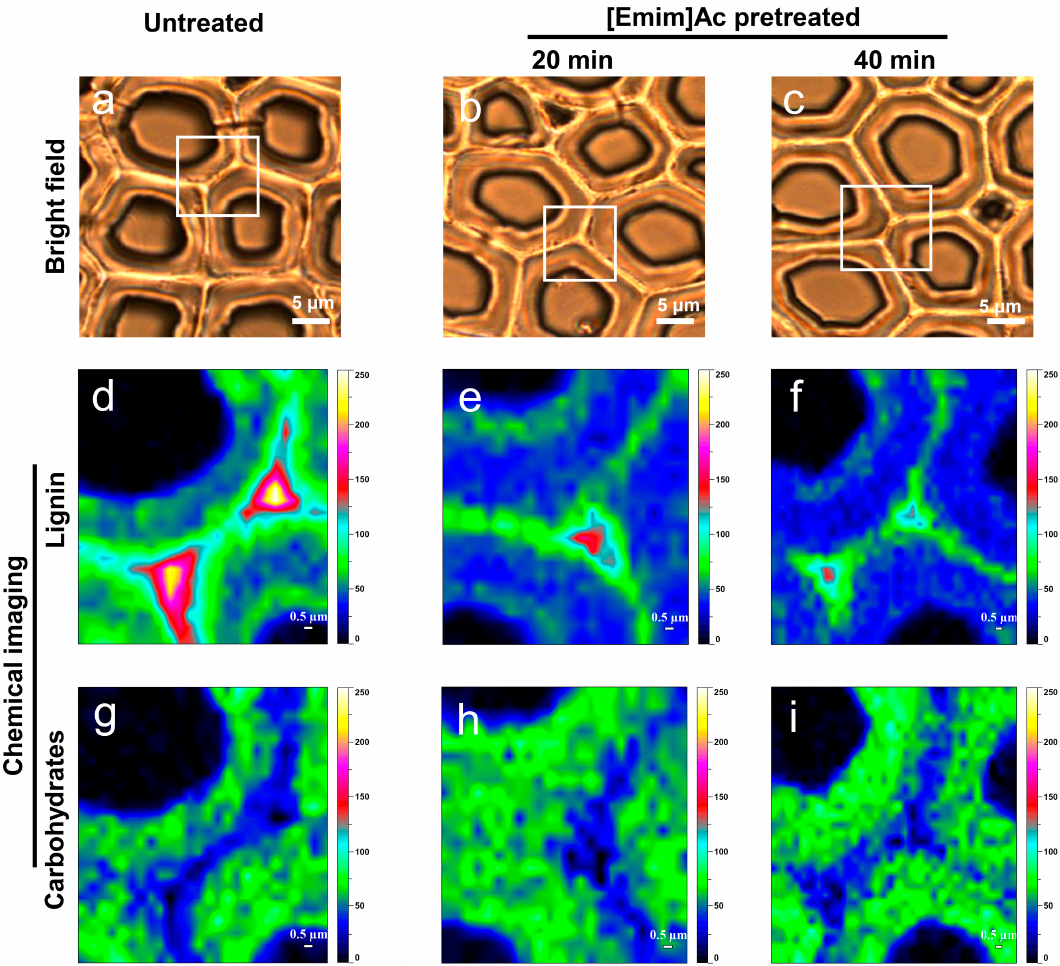
Figure 7. Raman mapping of poplar wood cell walls before and after [Emim]Ac pretreatment at 90 °C. Rectangles in bright field images ( a – c ) indicate the selected areas of mapping; ( d – f ) Lignin maps for untreated and IL pretreated poplar; ( g – i ) Carbohydrates maps for untreated and IL pretreated poplar.